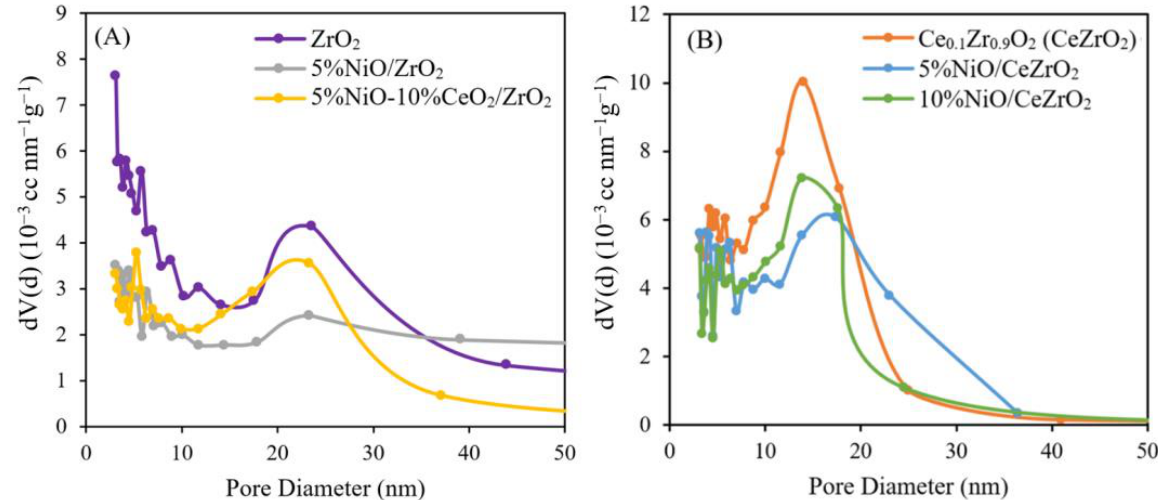
Figure 3. Pore distribution of catalyst: ( A ) ZrO 2 -supported NiO catalyst and ( B ) CeZrO 2 -supported NiO catalyst.